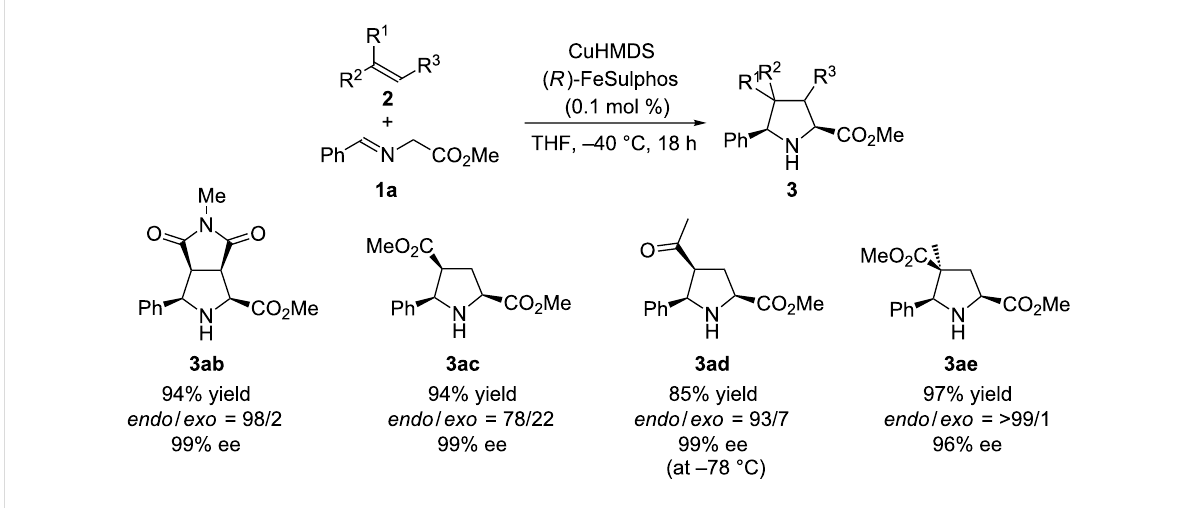
CuHMDS, which enables rapid deprotonation of the Schiff